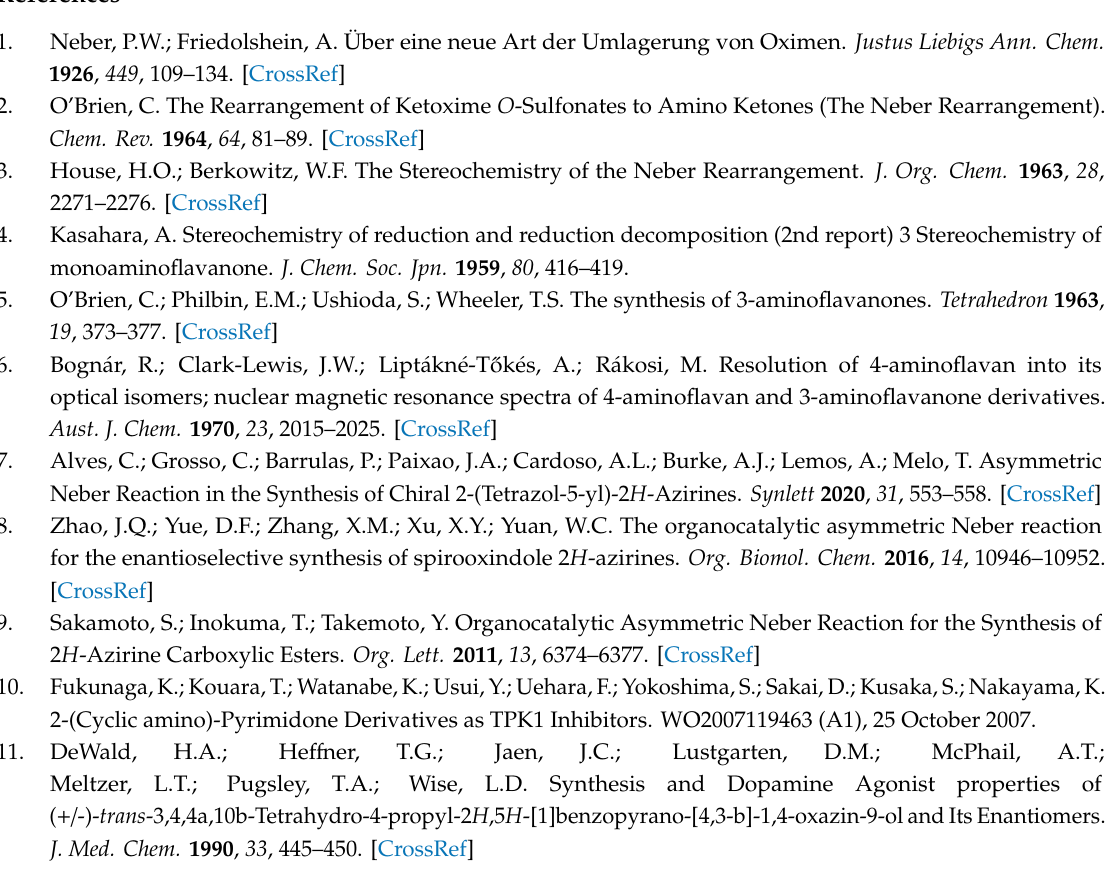
Table S1: Yields in the preparation of thiazole-condensed derivatives rac - 3a-g from rac-cis - and trans - 1a-g . Part 2. Antiproliferative activity experiments, Figures S262–S284; Chiral HPLC-ECD analysis, Figures S285–S338; ECD calculations, Figures S339–S348; X-ray analysis of 17e , Figure S349, Table S2: Experimental details of single crystal X-ray di ff raction measurement of 17e